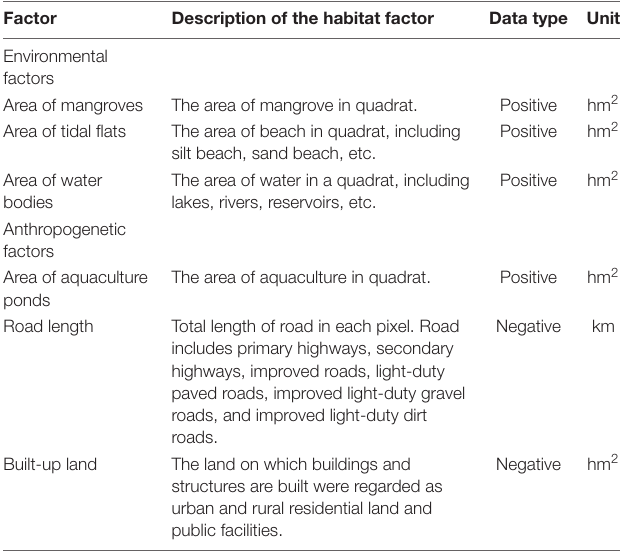
TABLE 2 | Environmental and anthropogenic variables considered in the present study. Factor Description of the habitat